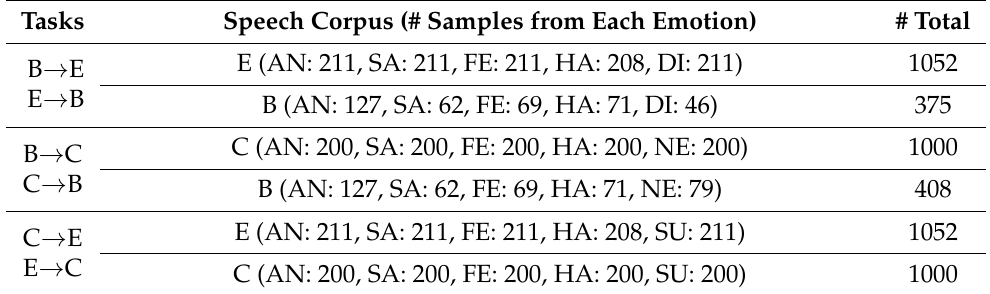
Table 1. The sample statistical information in all six cross-corpus SER